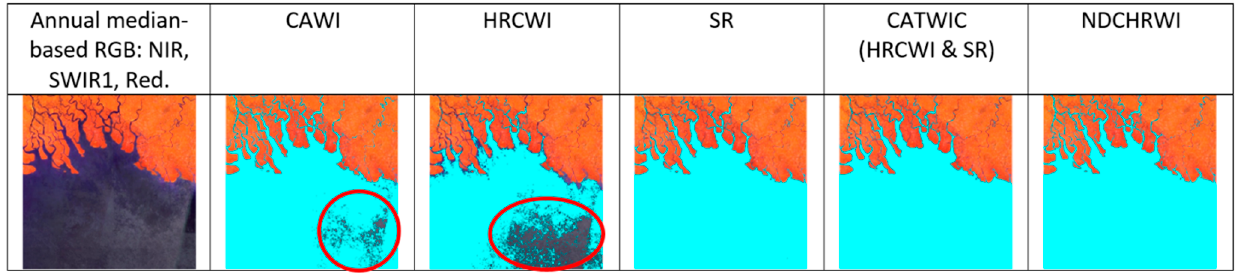
Figure 10. Comparison of atmospheric effects on the best performing indices. Location: Deception Bay, Papua New Guinea (144.5862, − 7.8875).